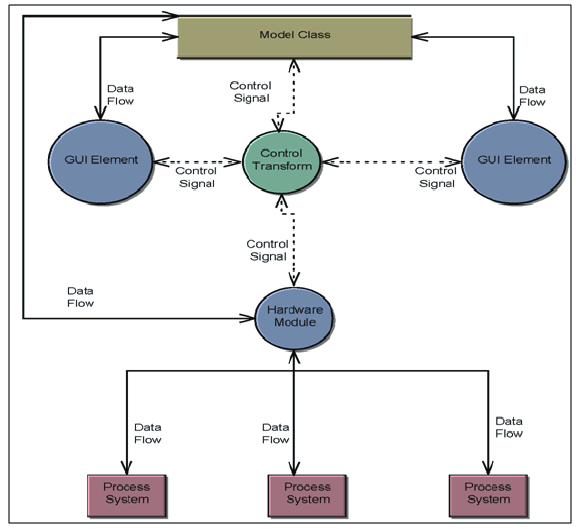
Fig.4: DFD (Data Flow Diagram) of the software